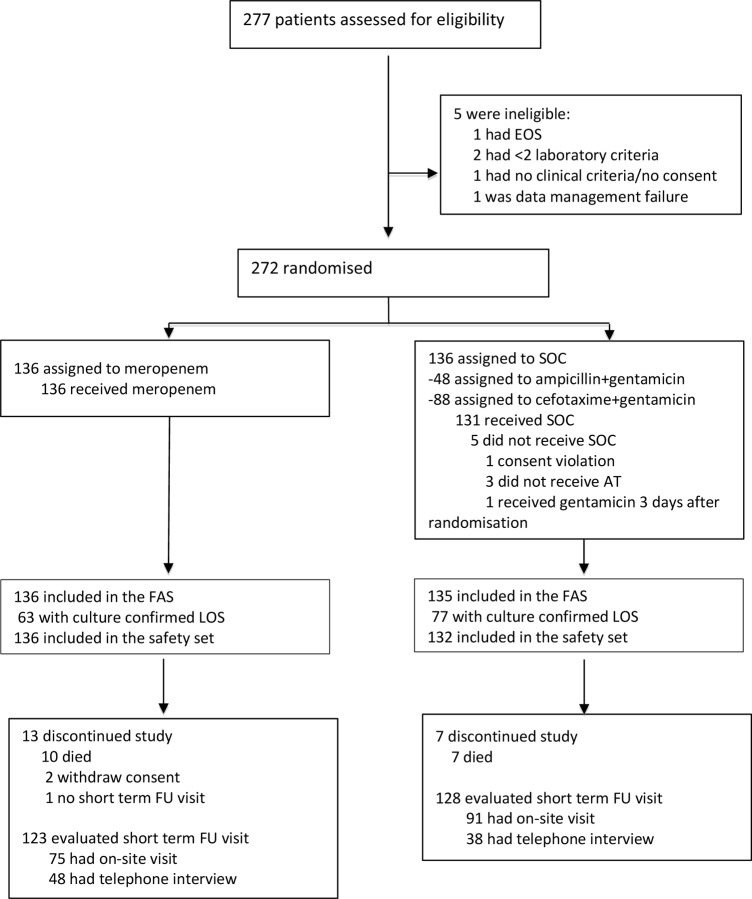
Flowchart of the study NeoMero-1.EOS–early onset sepsis; SOC–standard of care; FAS–full analysis set; AT–allocated therapy; LOS–late onset sepsis; FU–follow-up.